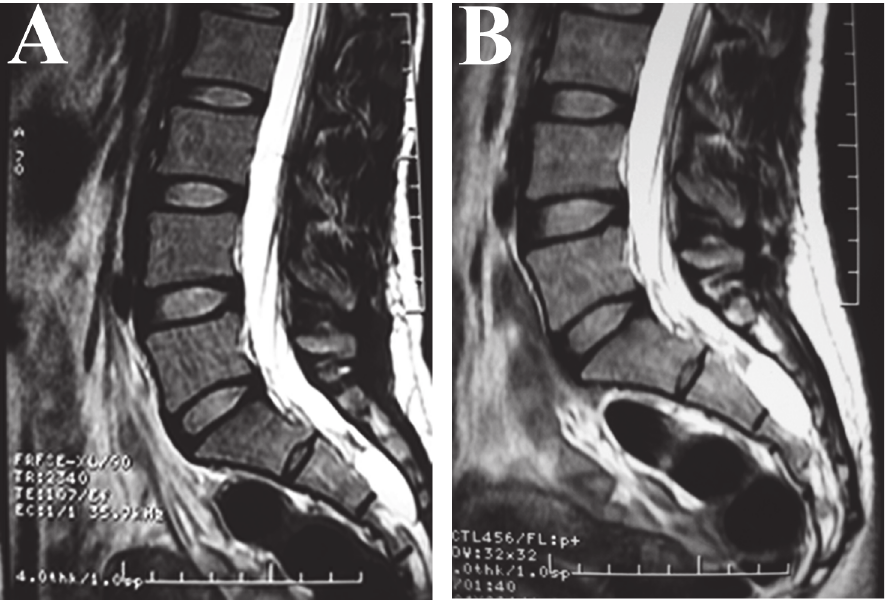
Fig 4. MRI study of no change of the cyst. A. Sagittal T2WI MRI shows a single cyst located in S2-S3 before fibrin gel therapy. B. Sagittal T2WI MRI obtained 10 months after operation shows that the size of the cyst did not